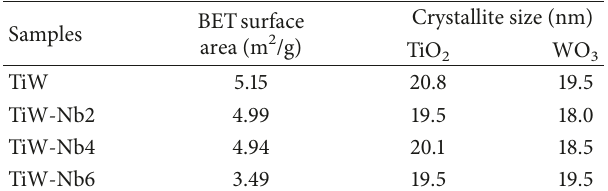
Table 1: BET surface area and crystal dimensions calculated from Scherrer’s equation.